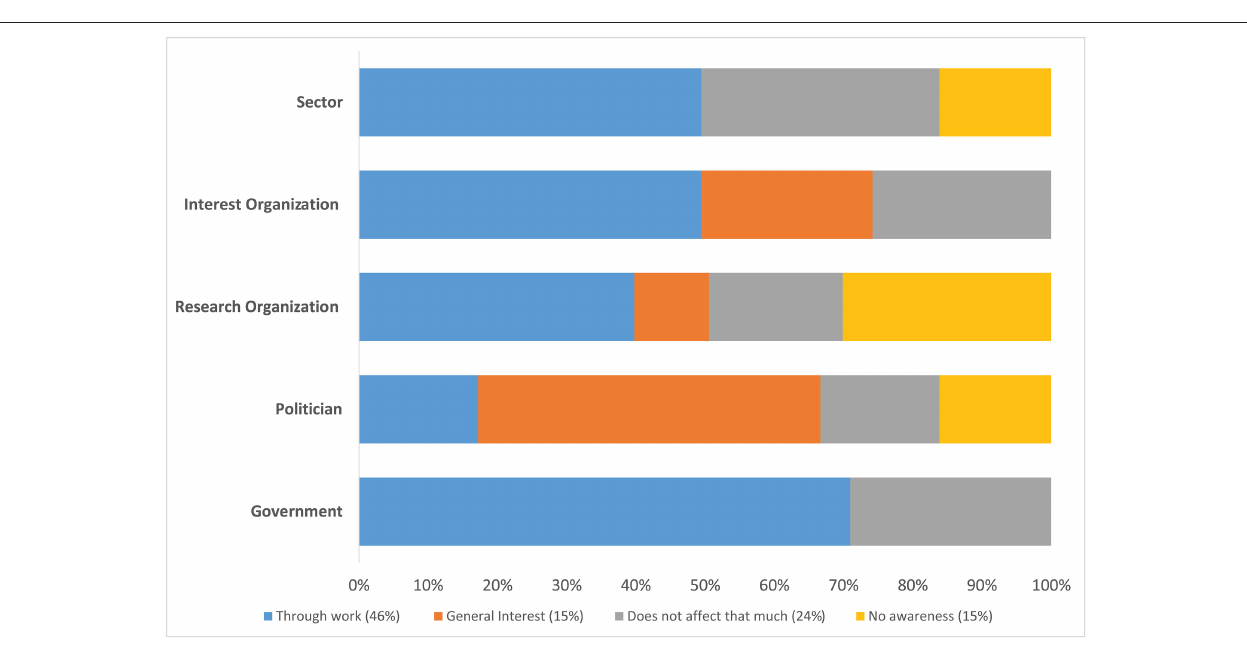
assessment of current scientific and societal knowledge with respect to the presence of MPs in the marine and